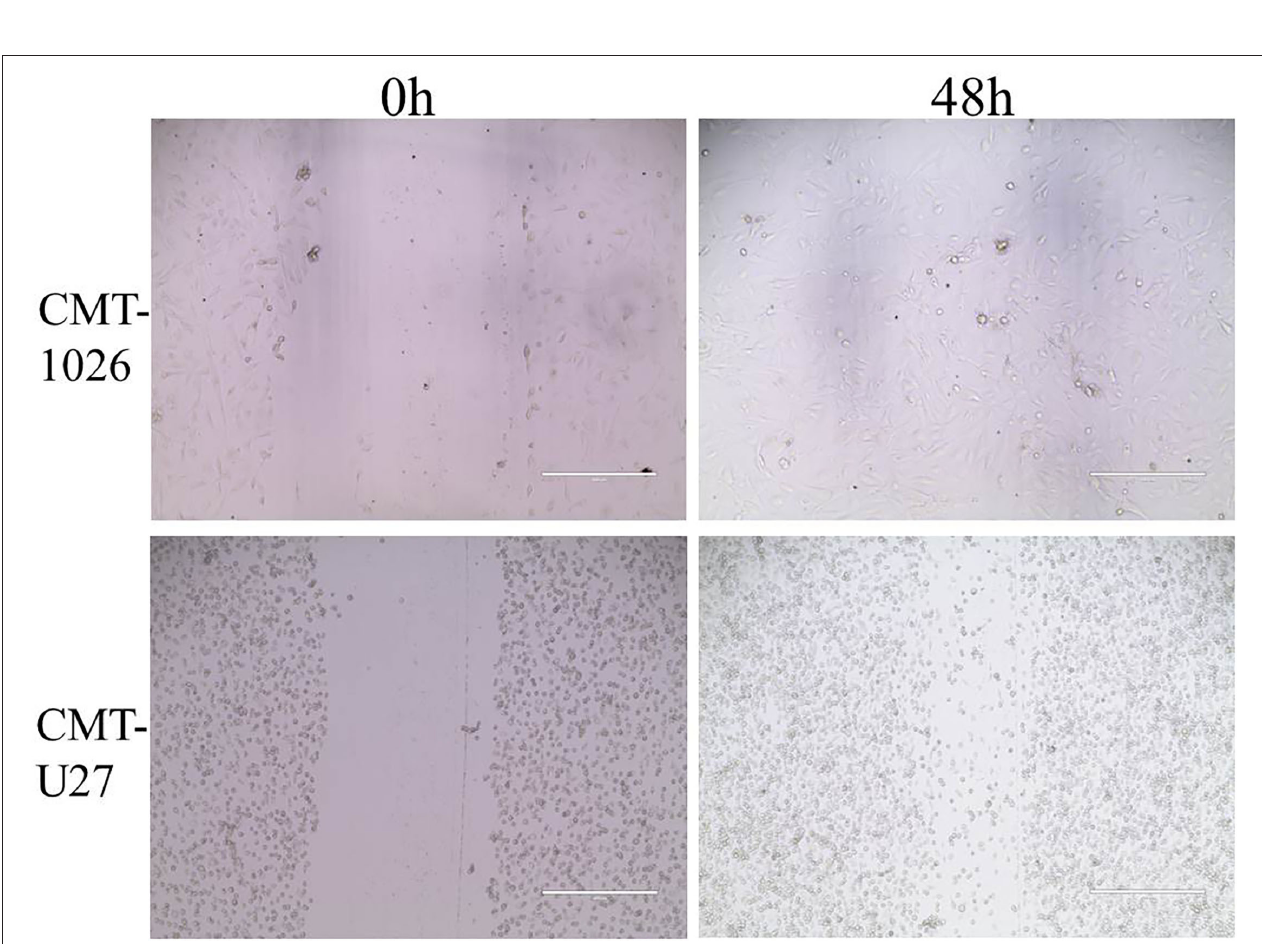
FIGURE 7 | Characteristic pictures of wound healing assays at 0 and 48h. At 48h after the scratch, CMT-1026 reached a wound healing percentage of 80.4% ± 1.22 compared with 78.2% ± 1.43 for CMT-U27 (mean ± SD).